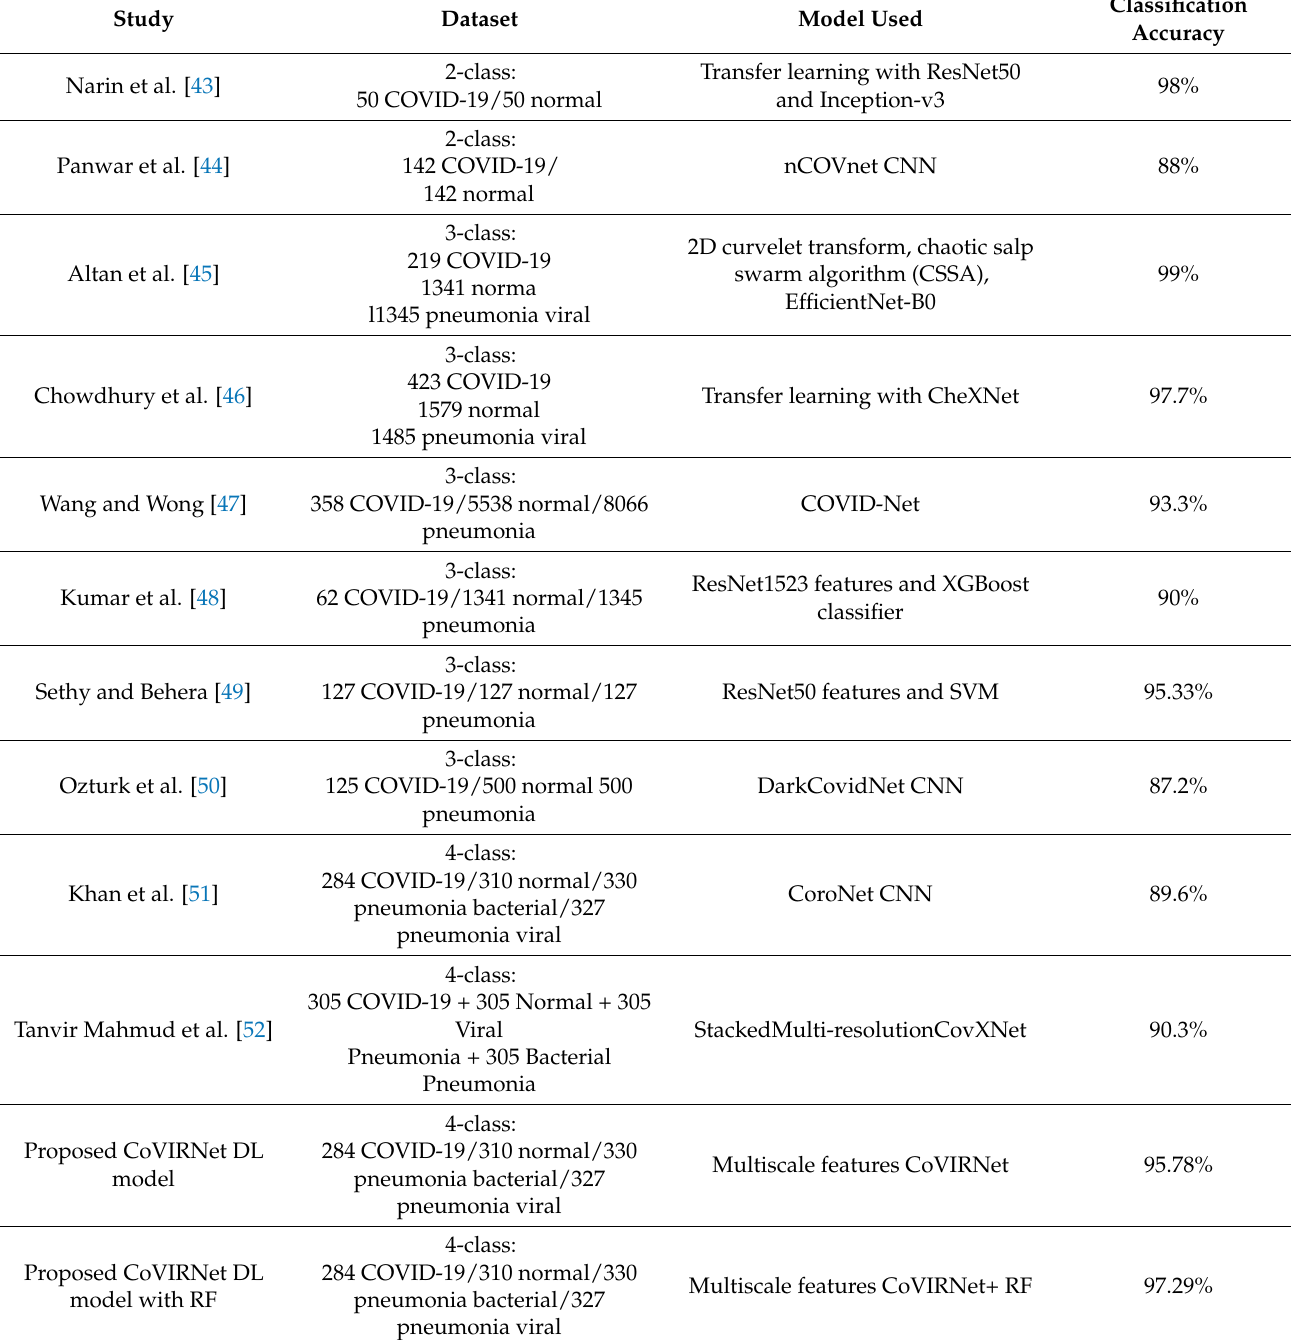
Table 4. The comparison study for COVID-19 classification using deep and ML